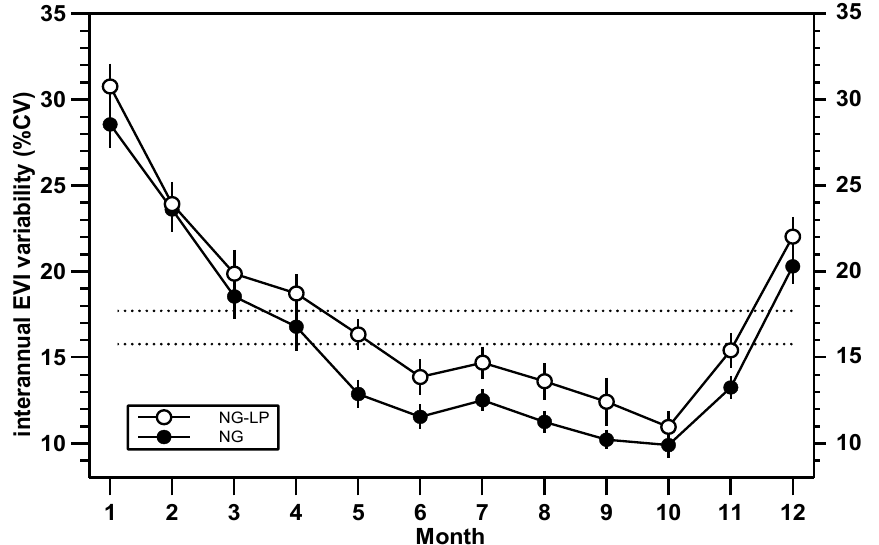
Figure 5. Interannual Enhanced Vegetation Index (EVI) variability of natural grassland (NG) and natural grassland overseed with legumes and fertilized with phosphorus (NG-LP), from January to December. Points corresponds to annual EVI mean of 20 paddocks (NG, n = 20; NG-LP, n = 20) during the nine years of the intensification practice. Error bars correspond to spatial standard error, horizontal dotted lines indicate the CV of the interannual EVI mean.